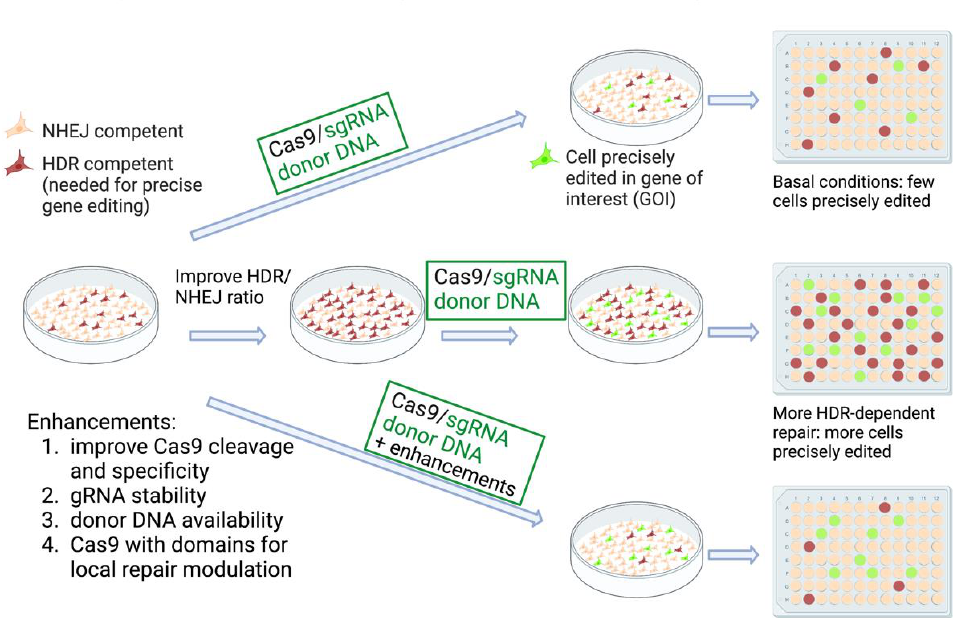
Figure 1. Increasing HDR-dependent repair improves yield of CRISPR knock-in cells. Knock-in HDR-dependent mutagenesis at a gene of interest (GOI). At the top, the basal conditions are shown, where few of the cells are HDR-competent. A fraction of these can be edited at the GOI following transfection with Cas9/gRNA and donor DNA. Isolating the desired knock-in edited cells from the total population can be challenging. In the center, cells are treated either genetically or pharmacologically to alter the HDR/NHEJ ratio. As a result, a higher yield of knock-in edited cells is achieved. The bottom row illustrates some methods used to improve HDR-dependent CRISPR editing. The increases in precisely edited cells depend on the method, the target cells and GOI. Created with BioRender.com.